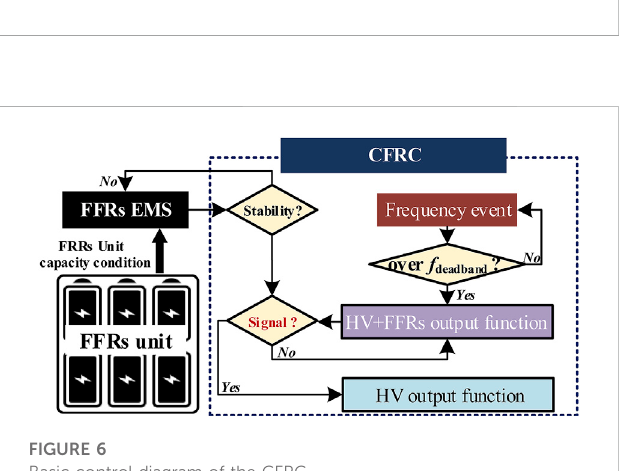
Frequency response curves with different ratios.